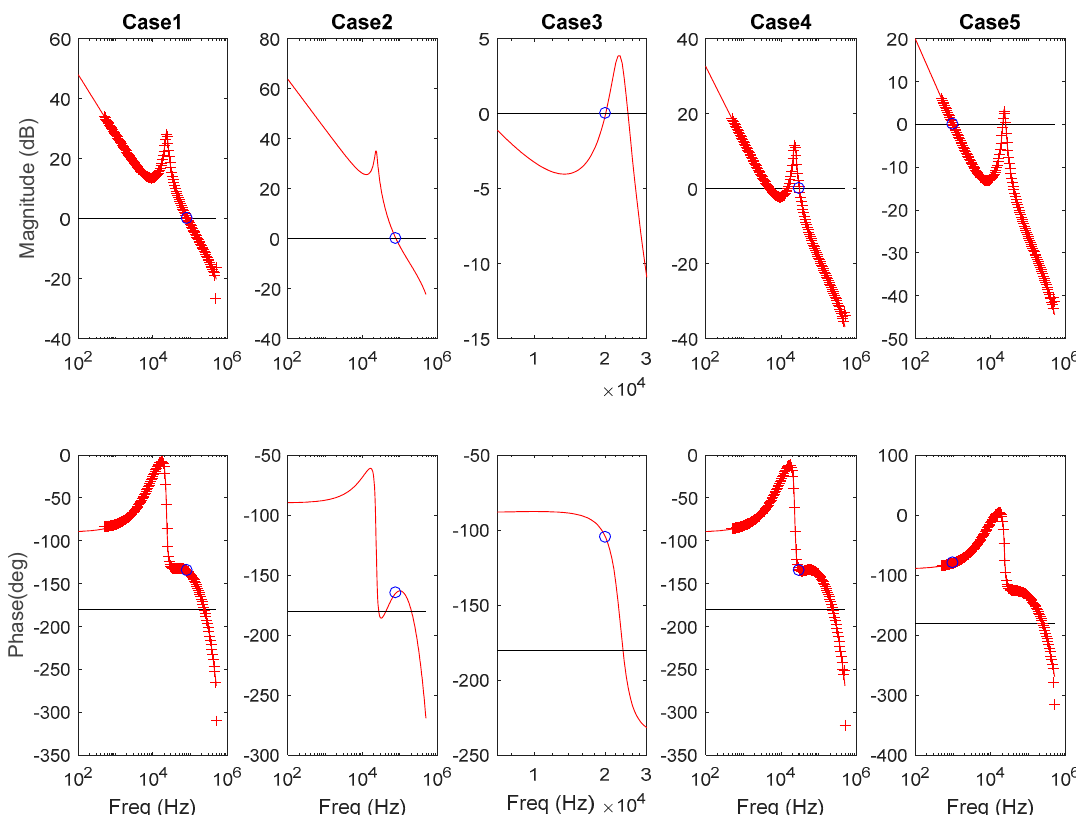
Figure 2. Open-loop transfer function for different combinations of crossover frequency and phase margin. Solid line: theoretical freq. response; crossed line: freq. response from the time-domain simulation with a PSIM simulator.